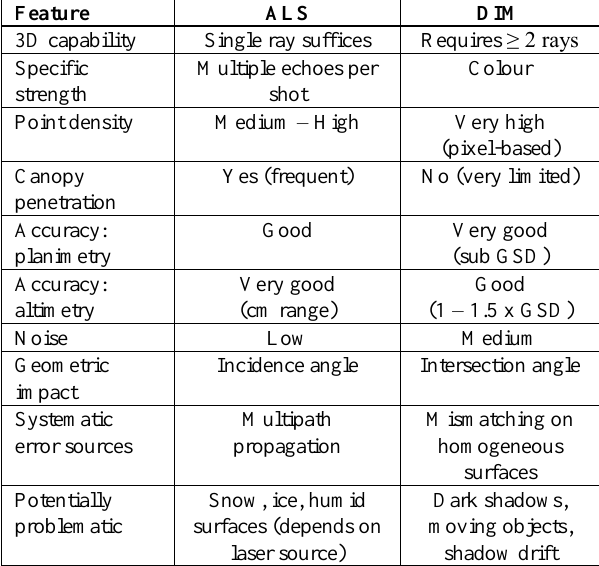
Table 1: Comparison of some important features of point clouds from ALS and